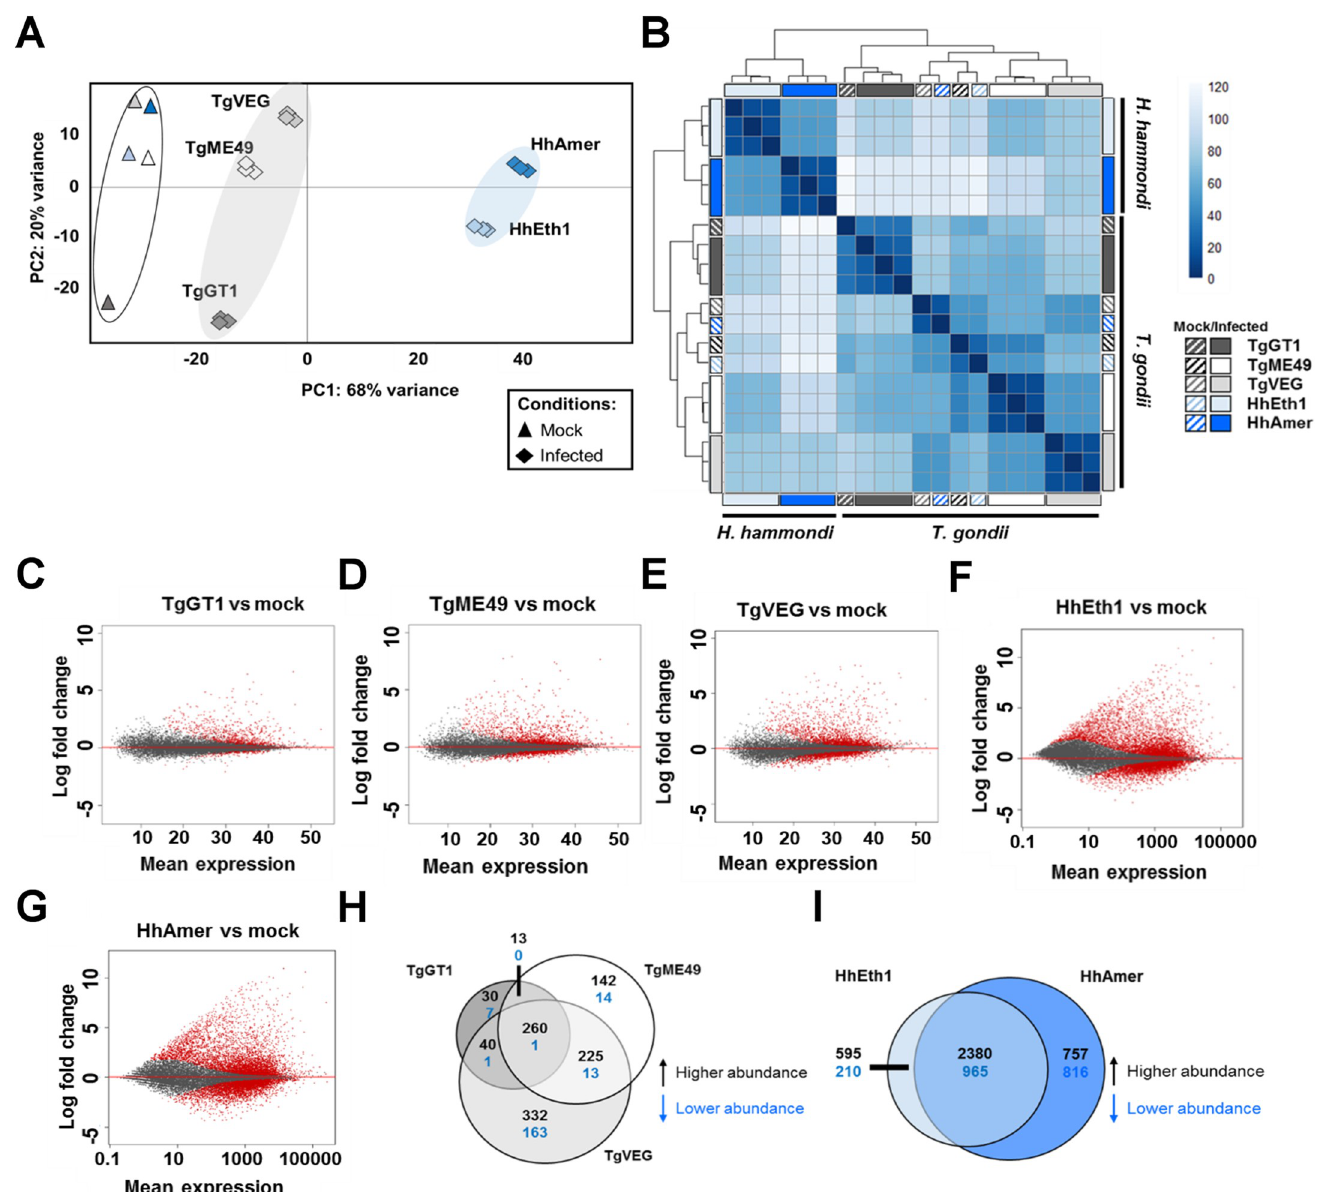
Fig 1. Unique transcriptome profiles of THP-1 cells infected with parasites where H . hammondi induced higher numbers of differentially expressed genes in THP-1 cells compared to T . gondii . (A) Principal components (PC) 1 and 2 of THP-1 cells infected ( ♦ ) or mock infected ( ▲ ) with T . gondii (TgGT1, Dark grey; TgME49, white; TgVEG, light grey) or H . hammondi (HhEth1, light blue; HhAmer, dark blue). THP-1 cells infected with T . gondii clustered together (light grey shading) while THP-1 cells infected with H . hammondi clustered together along PC1 (light blue shading). T . gondii and H . hammondi mock-infected cells ( ▲ ) also separated from the parasite-infected cells along PC2. (B) Heatmap showing Euclidean distance clustering between mock (striped boxes) and infected (solid filled boxes) THP-1 cell samples (log 2 -transformed data). (C-G) MA-plots of gene expression in THP-1 cells infected with T . gondii (Tg) or H . hammondi (Hh). Red dots ( ● ) represent genes of different abundance in infected THP-1 cells as compared to mock-infected THP-1 cells (alpha = 0.01). (H-I) Venn diagrams of genes in THP- 1 cells infected with T . gondii (H) or H . hammondi (I; p adj < 0.01, log 2 fold-change � 1 or � -1).